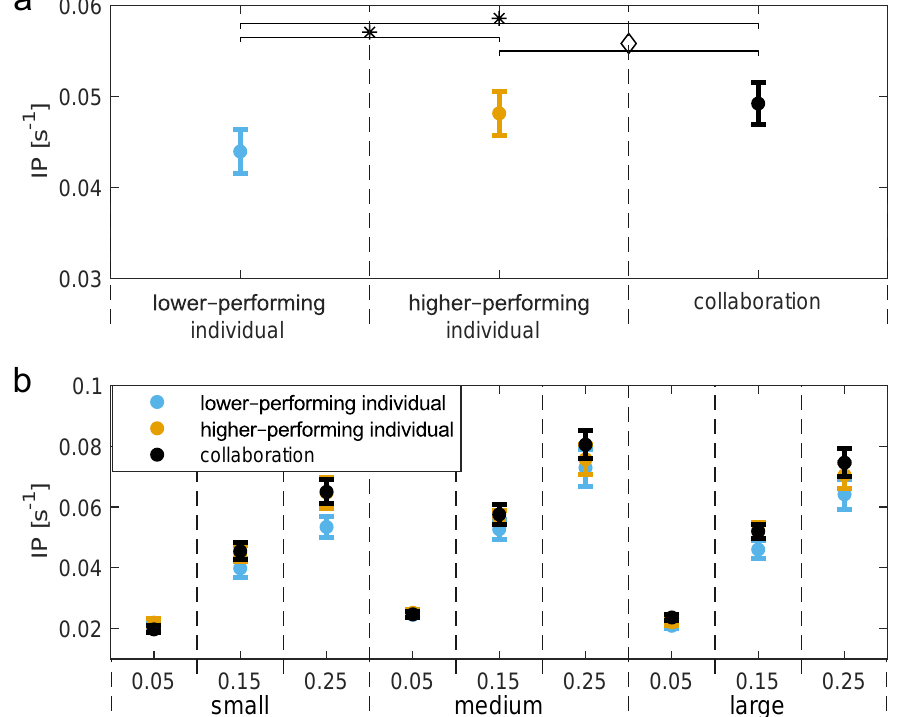
Figure 5. Task performance of individual subjects and subjects in collaboration for ( a ) whole experi- ment and for ( b ) each target separately. The task performance for each experiment is defined using Fitts’ law index of performance (IP), where the performance is better with higher values. Note that ∗ denotes significant statistical difference and (cid:5) denotes no statistical